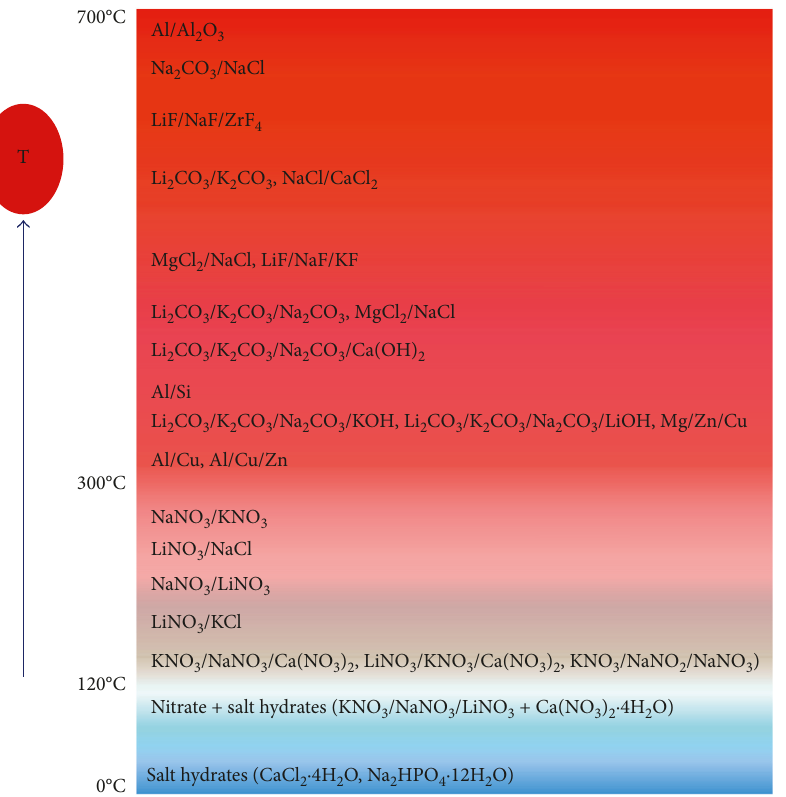
Figure 1: The relationship of the melting point and inorganic